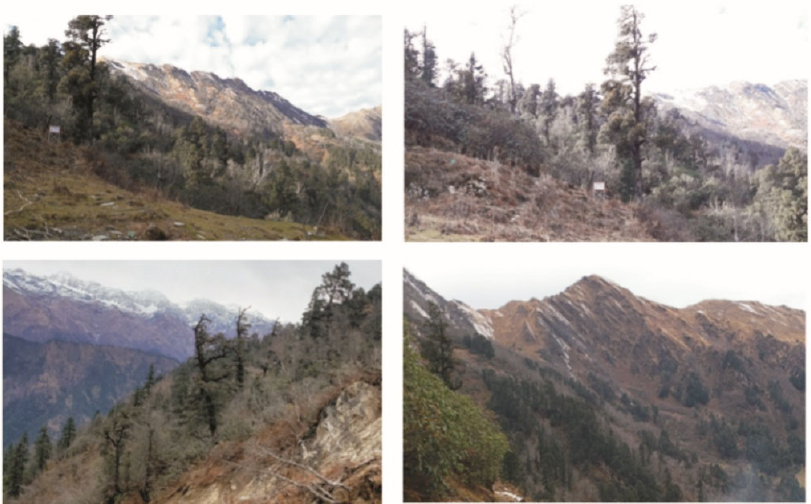
Figure 2. Vegetation distribution at the study site Magguchatti, near Triyuginarayan, Kedarnath in the Uttarakhand region, western Himalaya.